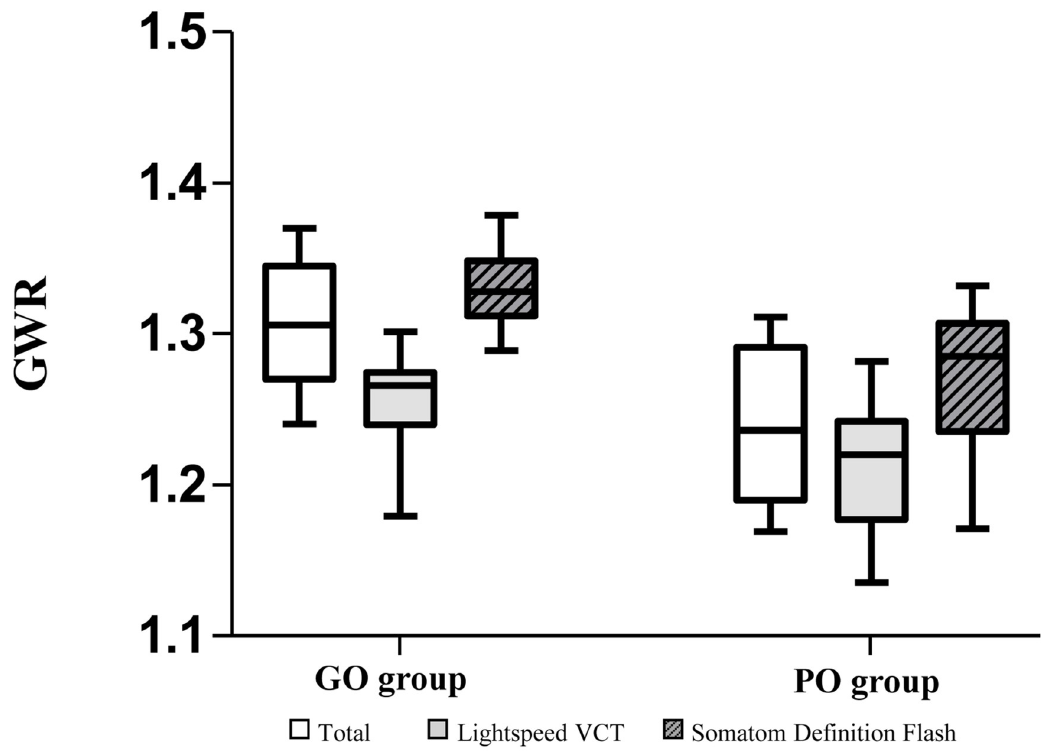
Fig 2. Box-plot is showing the comparison of GWR between each neurologic outcome group. GWR, gray-to-white ratio; GO, good neurologic outcome; PO, poor neurologic